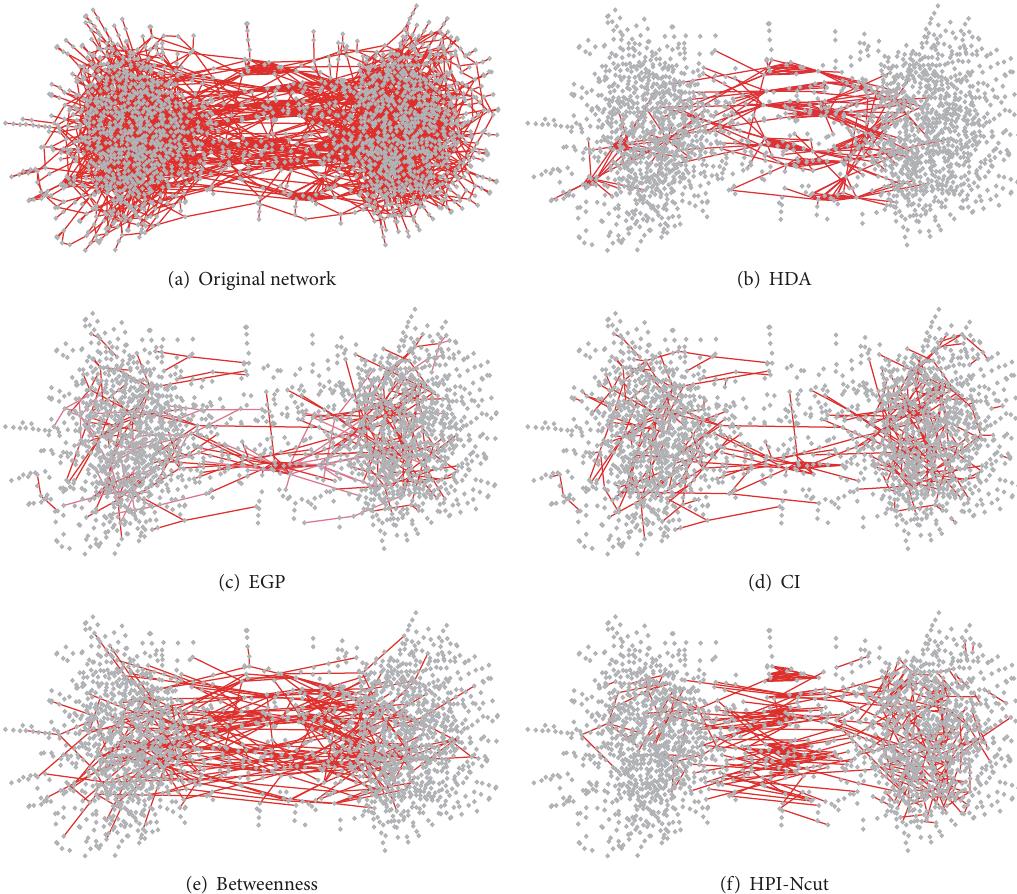
Figure 6: The schematic diagram of the removed links in a SBM network with two clusters. (a) is the original network with all the links. (b)–(f) are the top 10% links (i.e., 373 links) removed by different